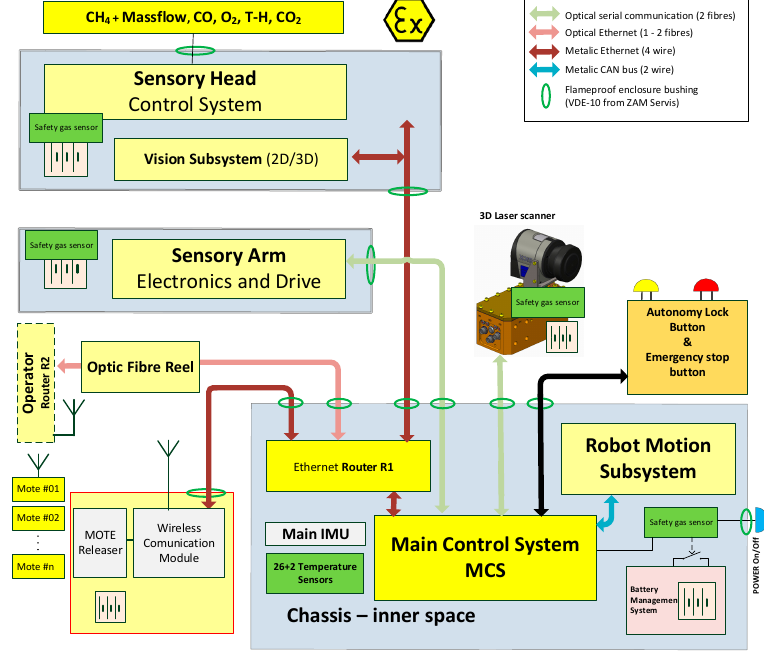
Figure 6. Separation of TeleRescuer subsystems.